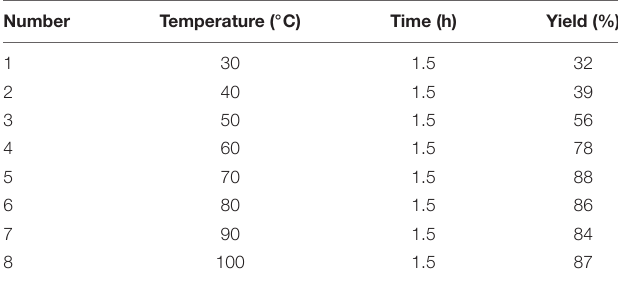
TABLE 2 | Optimization of the temperature of reaction to produce compound 3 .